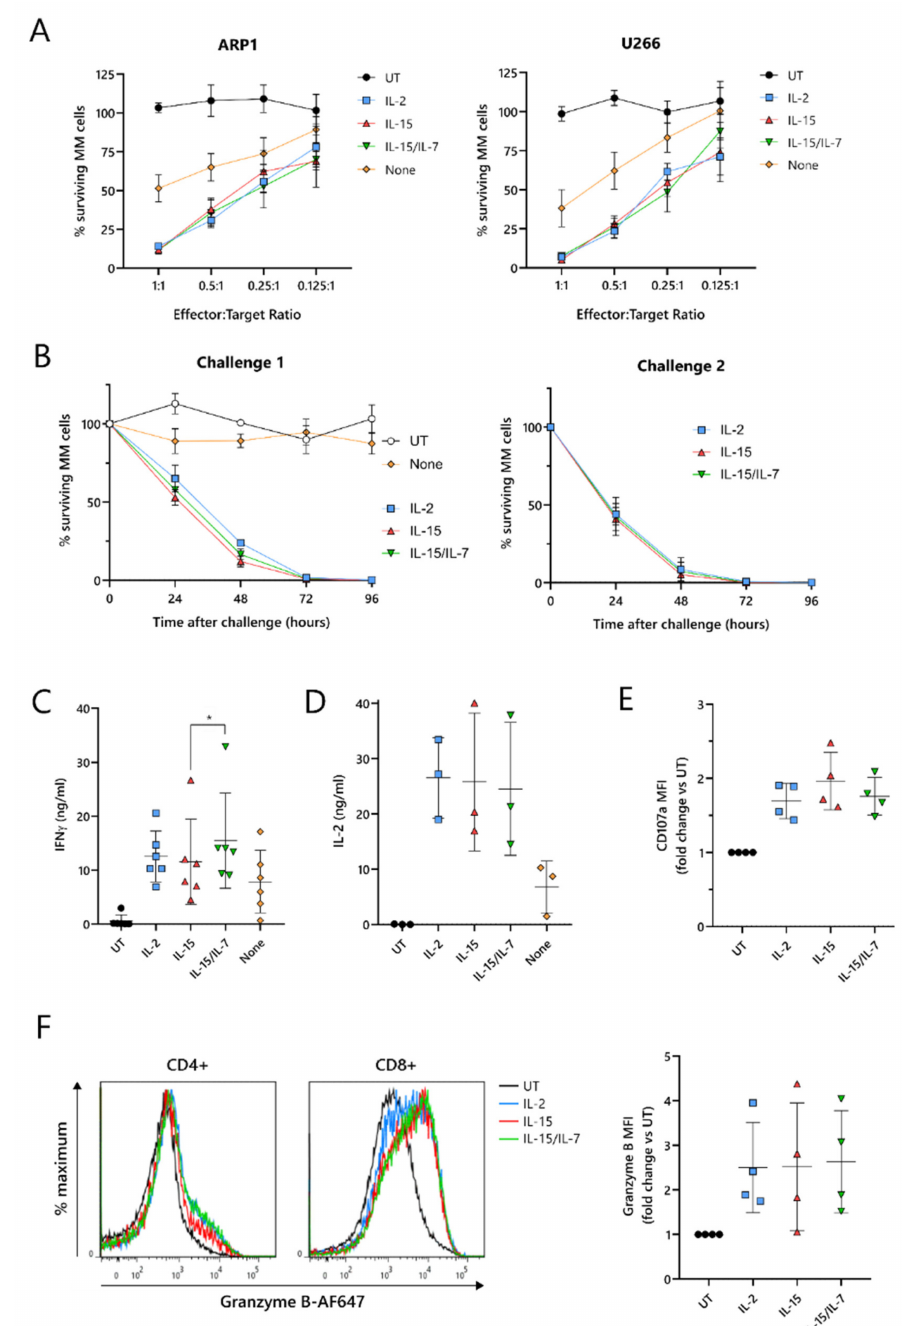
Figure 2. IL-15-grown ARI2h BCMA-CARs are highly functional. UT and ARI2h-transduced (ARI2h IL-2 , ARI2h IL-15 , ARI2h IL-15/IL-7 , ARI2h None ) T cells were co-cultured with ARP-1 cells for 24 h ( A ), 96 h ( B ) or 6 h ( C – F ) or U266 cells for 24 h ( A ). ( A ) Survival of GFP-ffLuc-expressing ARP-1 (left) or U266 (right) multiple myeloma (MM) cell lines, following a 24-hour co-culture with UT or ARI2h cells at the indicated T cell:tumor cell line (effector:target) ratios ( n = 5). ( B ) Survival of GFP-ffLuc-expressing ARP-1 cells following a 96-hour co-culture with UT or ARI2h cells, measured every 24 h. Graphs show the results of a first co-culture (left) and a second challenge (right) of ARI2h IL-2 , ARI2h IL-15 and ARI2h IL-15/IL-7 cells with fresh ARP-1 cells. All challenges were performed at a 0.125:1 effector:target ratio ( n = 3). ( C , D ) Levels of released IFN γ ( C ) and IL-2 ( D ), as measured by ELISA. ( E ) Summary of the surface expression of CD107a on CD8 + (UT) or CD8 + CAR + T cells, based on the MFI and normalized to UT. ( F ) Left—representative histograms showing granzyme B staining in UT or CAR + CD4 + and CD8 + T cells. Right—summary of the granzyme B expression in CD8 + (UT) or CD8 + CAR + T cells, based on the MFI and normalized to UT. * p <